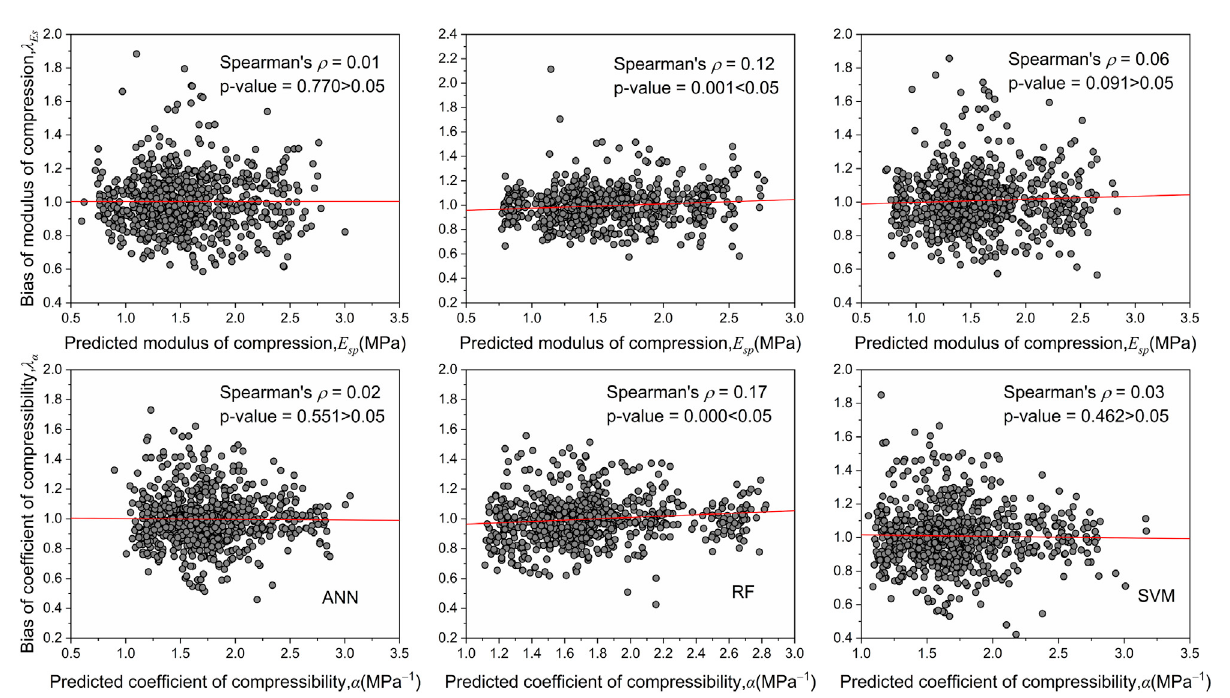
FIGURE 9 Plots of model biases versus predicted compression indices for the ANN, RF, and SVM models.